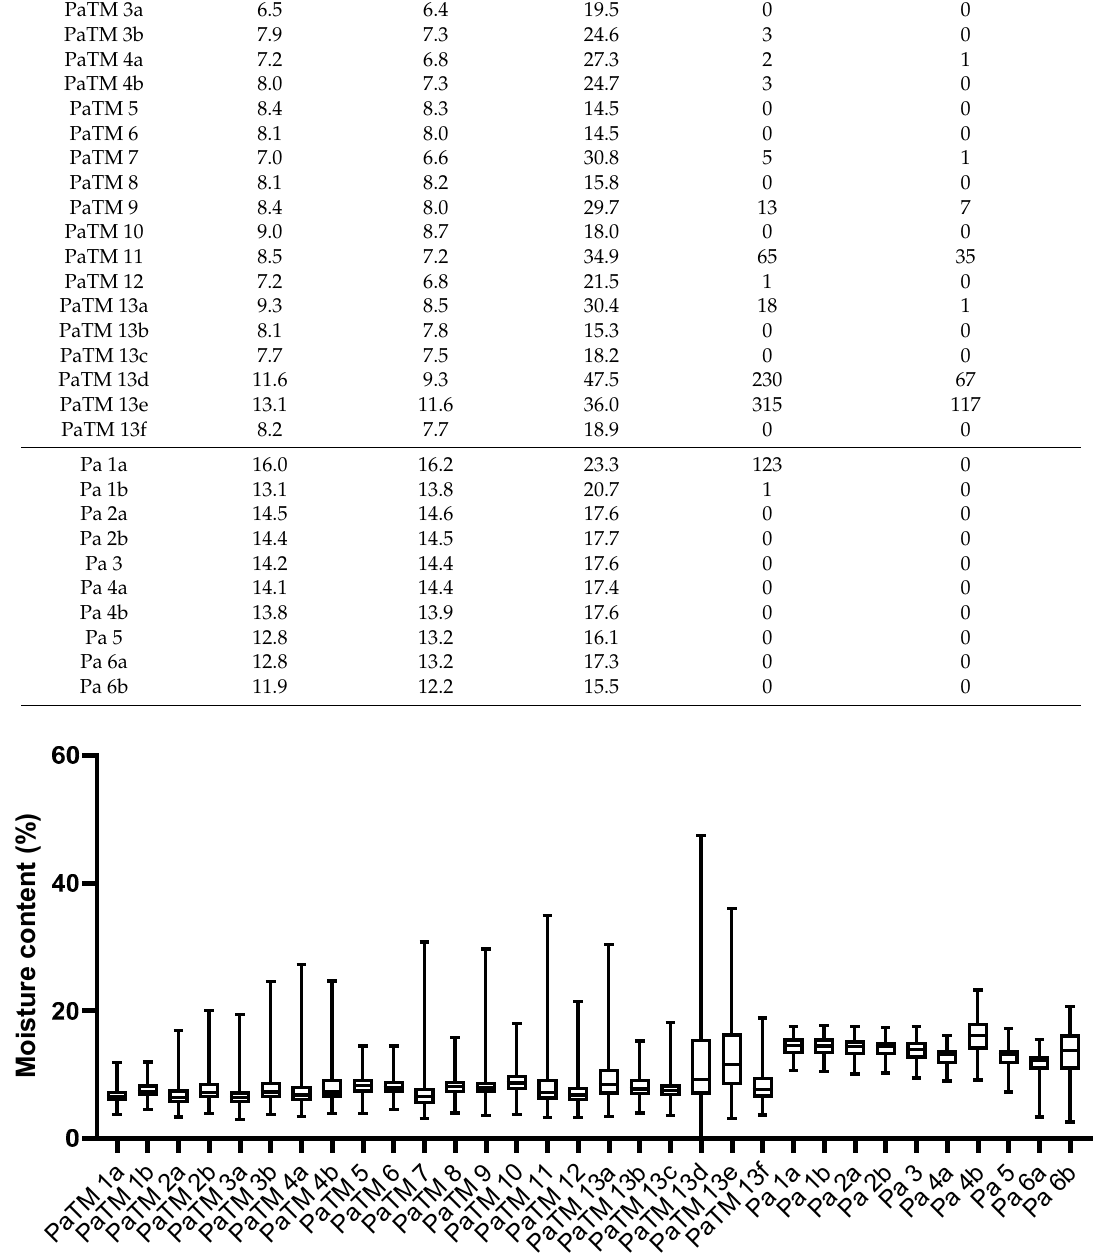
Figure 7. Influence of the distance from the ground on the wood moisture content of the façade on the monitored Annex of the Wood Science and Technology building in Ljubljana in the period between 13th of July 2016 and 15th of July 2019.